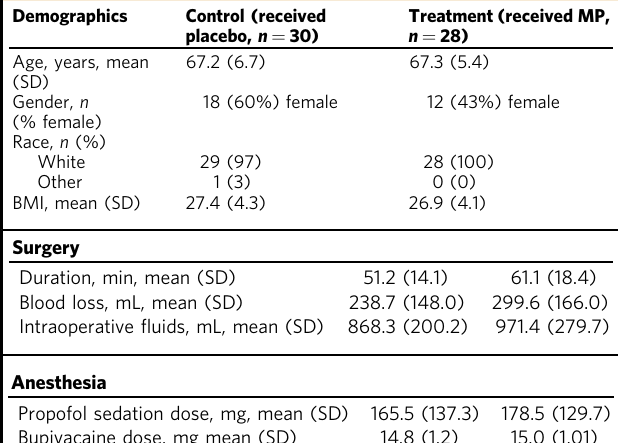
Table 1. Samples suitable for analysis with mass cytometry were